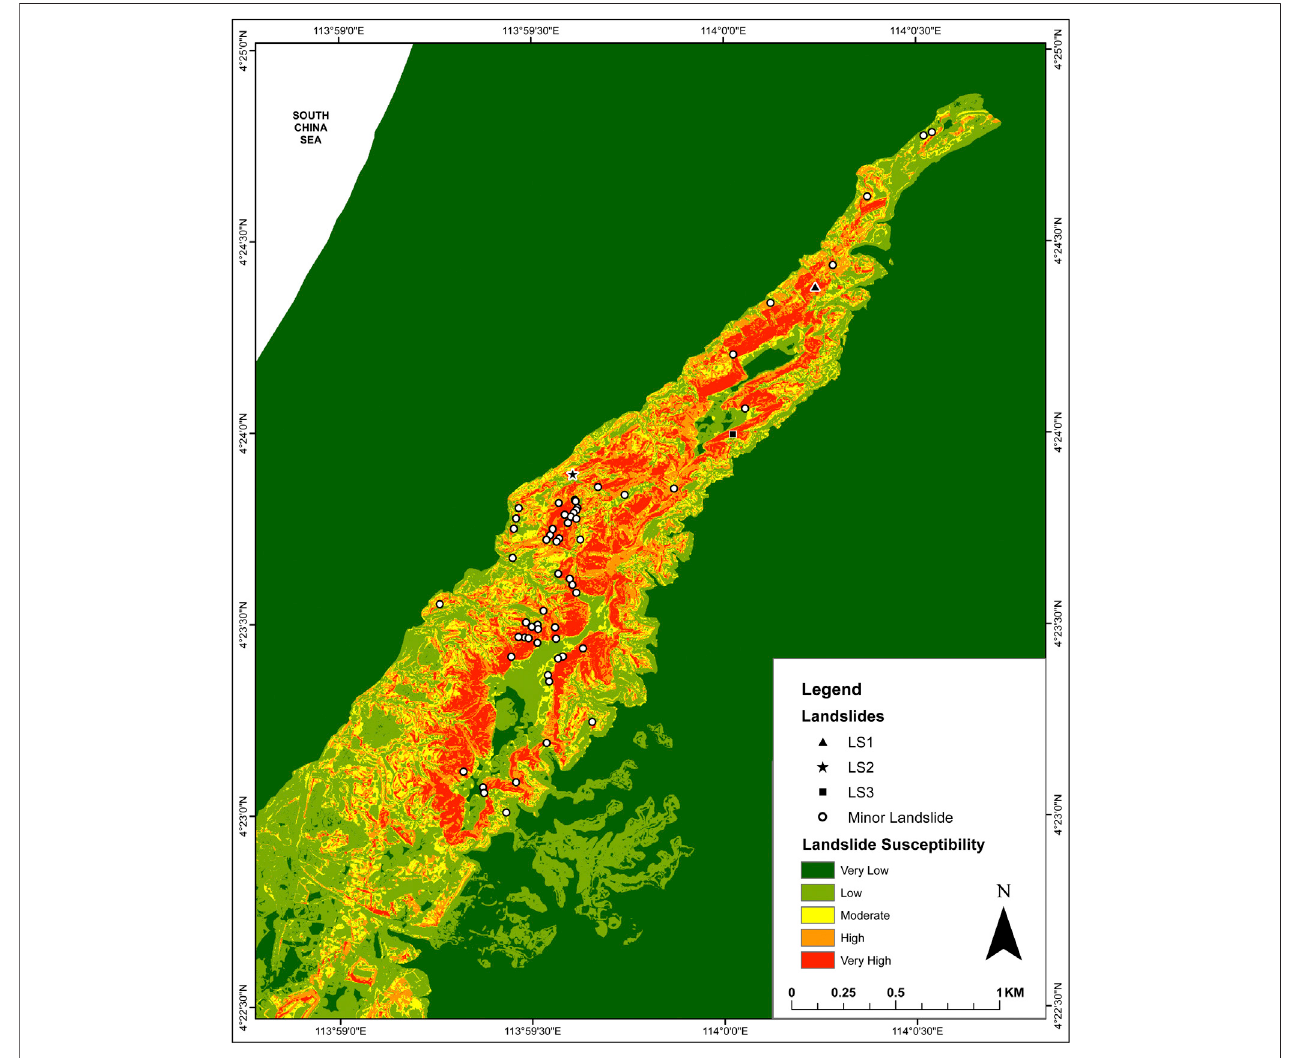
FIGURE 7 | Revised landslide susceptibility map of Canada Hill where the parameter slope aspect was replaced with planar failure potential.